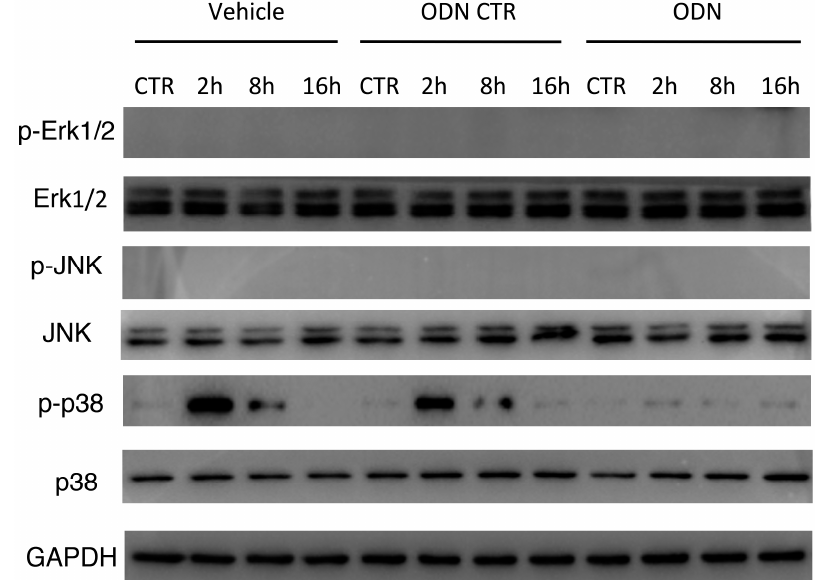
Figure 6. Intra-peritoneal administration of mtDNA leads to p38 MAPK activation via TLR9. WT mice were randomly assigned a group pretreated with TLR9 specific inhibitor ODN2088 or a control group. Mice in the ODN2088 group were pretreated 1h before mtDNA administration ( n = 8/group). Total and phosphorylation levels of ERK1/2, JNK, and p38 expression in lung tissue were measured by Western blot. Three separate independent experiments got the similar results.